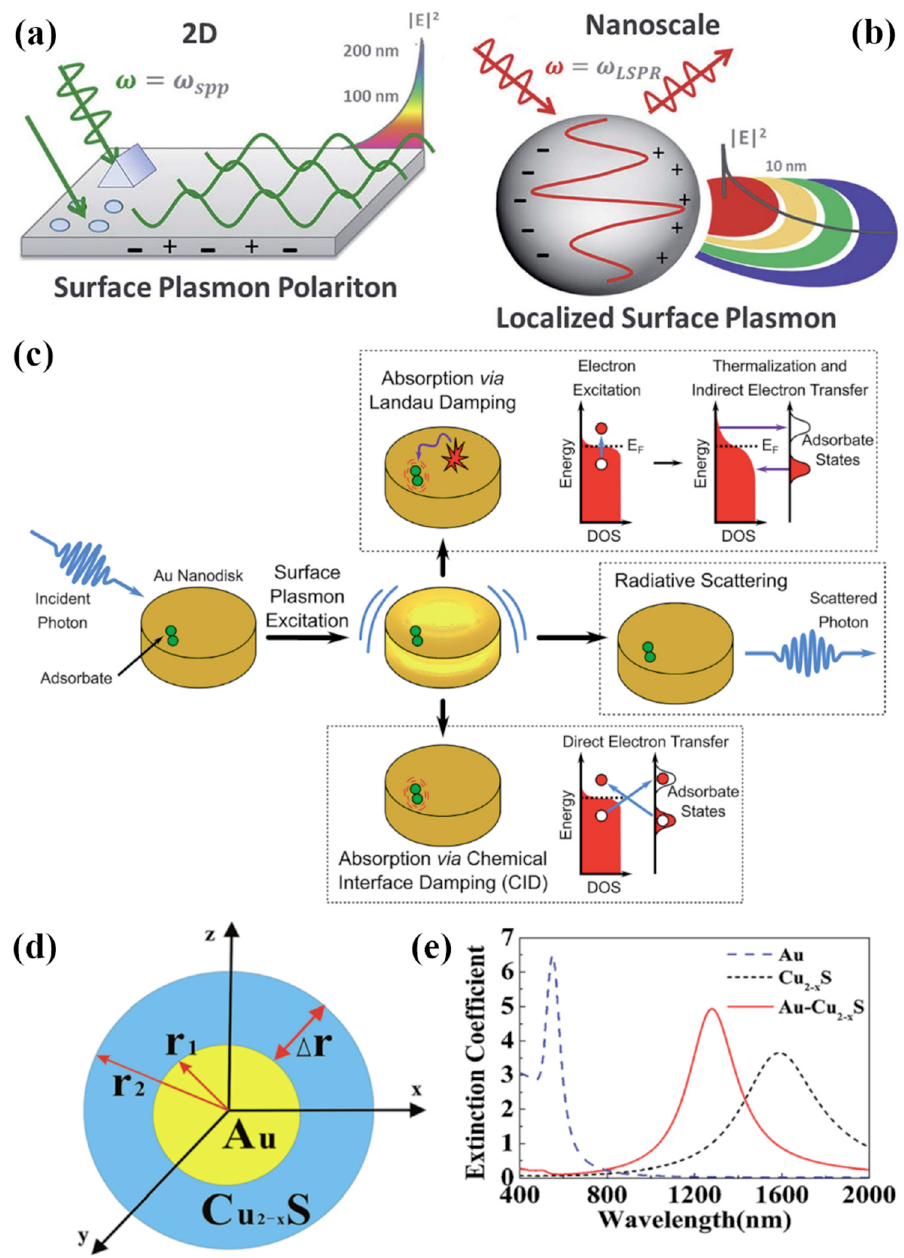
Figure 1. Basic principles of plasmonics. ( a , b ) The two types of surface plasmons with propagating surface plasmon polaritons along the surface of a thin film at the SPP resonant frequency in ( a ) and localized surface plasmons confined to the surface of a plasmonic nanoparticle at the LSPR resonant frequency in ( b ), where the amplitude of the electric field of light weakens further from the surface of each structure. Adapted with permission from Ref. [12]. Copyright Royal Society of Chemistry (2015). ( c ) Three possible decay mechanisms of surface plasmons, where hot electrons can be generated and indirectly transferred via Landau Damping, directly transferred via Chemical Interface Damping, or not produced during re-emittance of a photon in Radiative Damping. Reproduced with